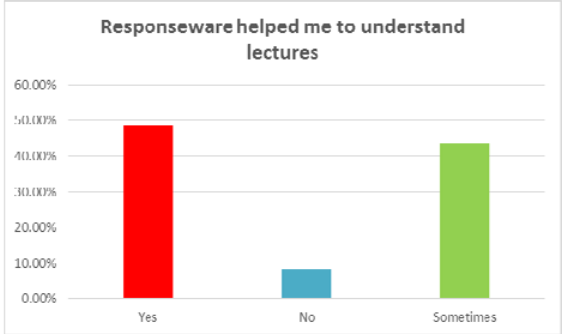
Figure 5. Responseware app usefulness for students